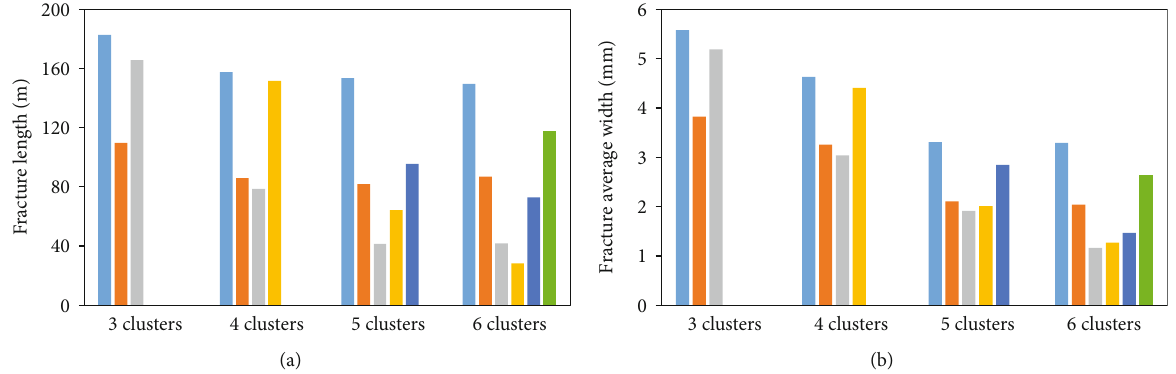
Figure 4: Length (a) and average width (b) of multifracture in a stage with di ff erent cluster